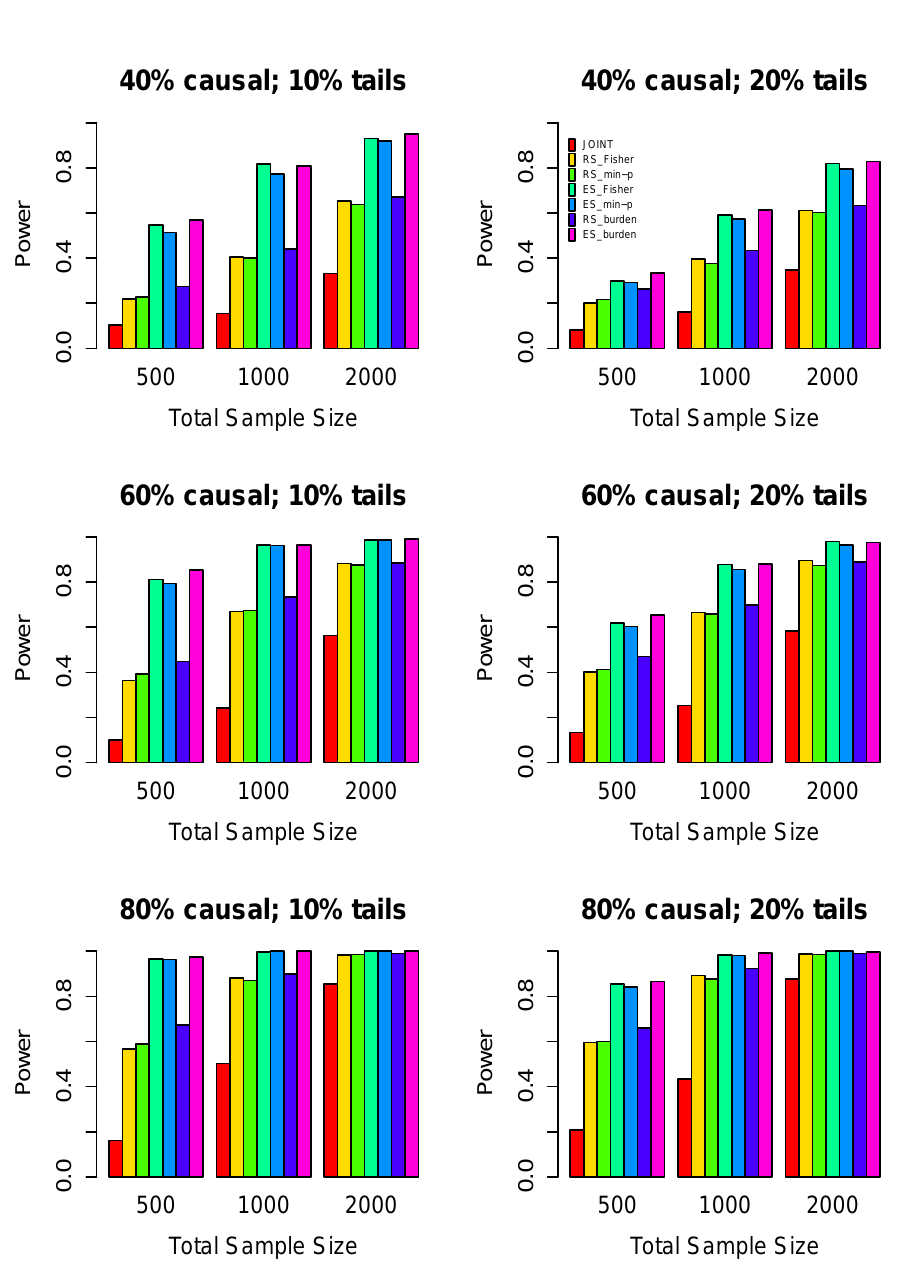
Figure 3. Power comparisons of seven tests when all causal variants have the same effect direction. The left panel considers 10% high/low extreme phenotype sampling with the three rows corresponding to 40%, 60%, and 80% causal variants. The right panel considers 20% high/low extreme phenotype sampling. Three sample sizes are considered: n =500, 1000, 2000. Powers are estimated at the 0.05 significance